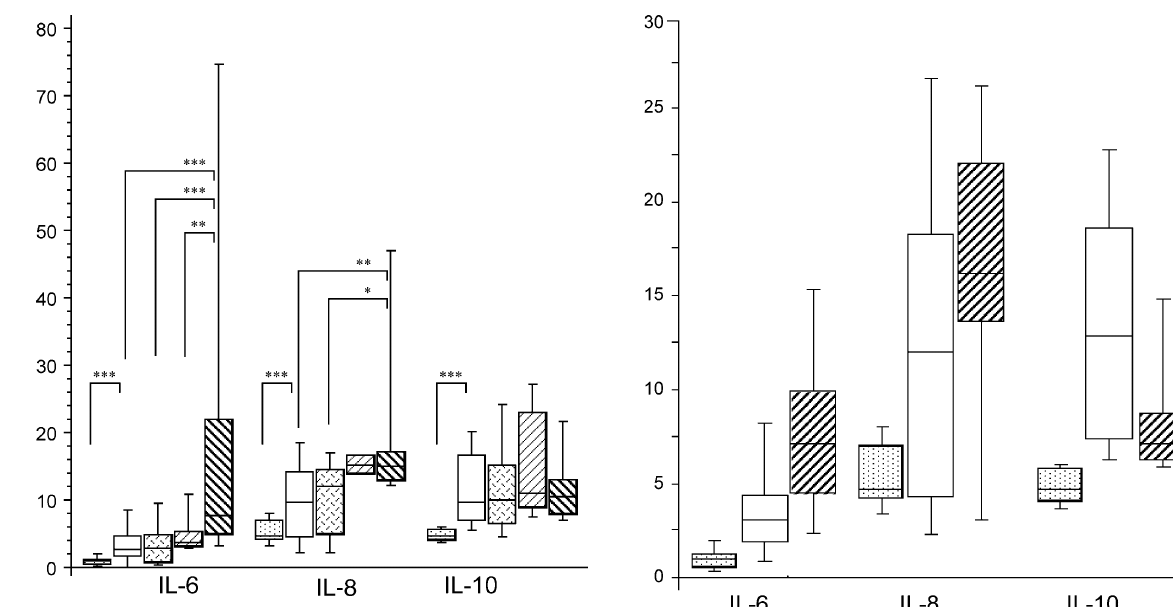
FIG. 3. Circulating cytokine levels from vasculitis patients in the stable phase, separated according to subsequent devel- opment of overt relapse. , results from 11 patients who did relapse within the following 3-month period; , results from 40 patients where no relapse was detected for at least 3 months (for 80 IL-6 patients); , healthy control group.